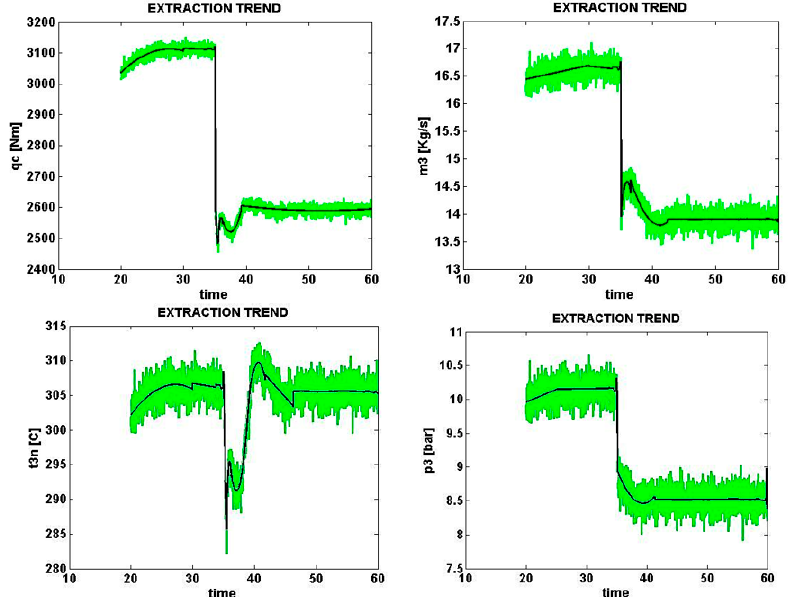
Figure 10. Occurrence of partial shadow amounting to +0.2% error.